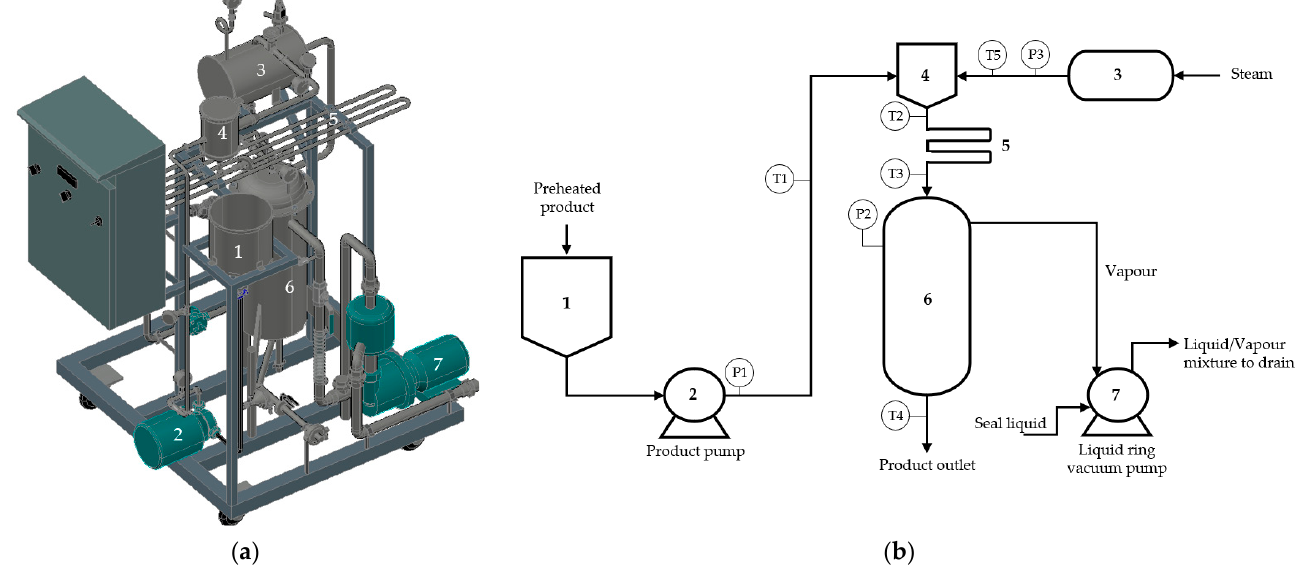
Figure 1. Impingement steam jet sterilizer prototype ( a ) and schematic diagram of continuous flow sterilizer using impingement steam jet technique ( b ): (1) the product buffer tank; (2) the product pump; (3) the steam storage tank; (4) the impingement tank; (5) the holding tube; (6) the vacuum chamber; (7) the vacuum pump; the temperature sensor at (T1) the product infeed, (T2) sterilization, (T3) after the holding tube, (T4) after the vacuum cooler, (T5) the steam infeed; the pressure gauges at (P1) the product pump, (P2) the vacuum cooler, (P3) the steam infeed.